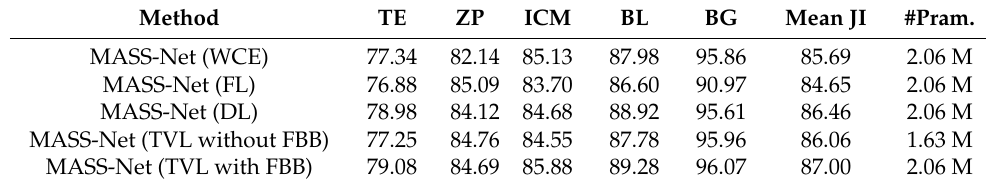
Table 2. MASS-Net ablation study results. (#Pram. show the number of trainable parameters).